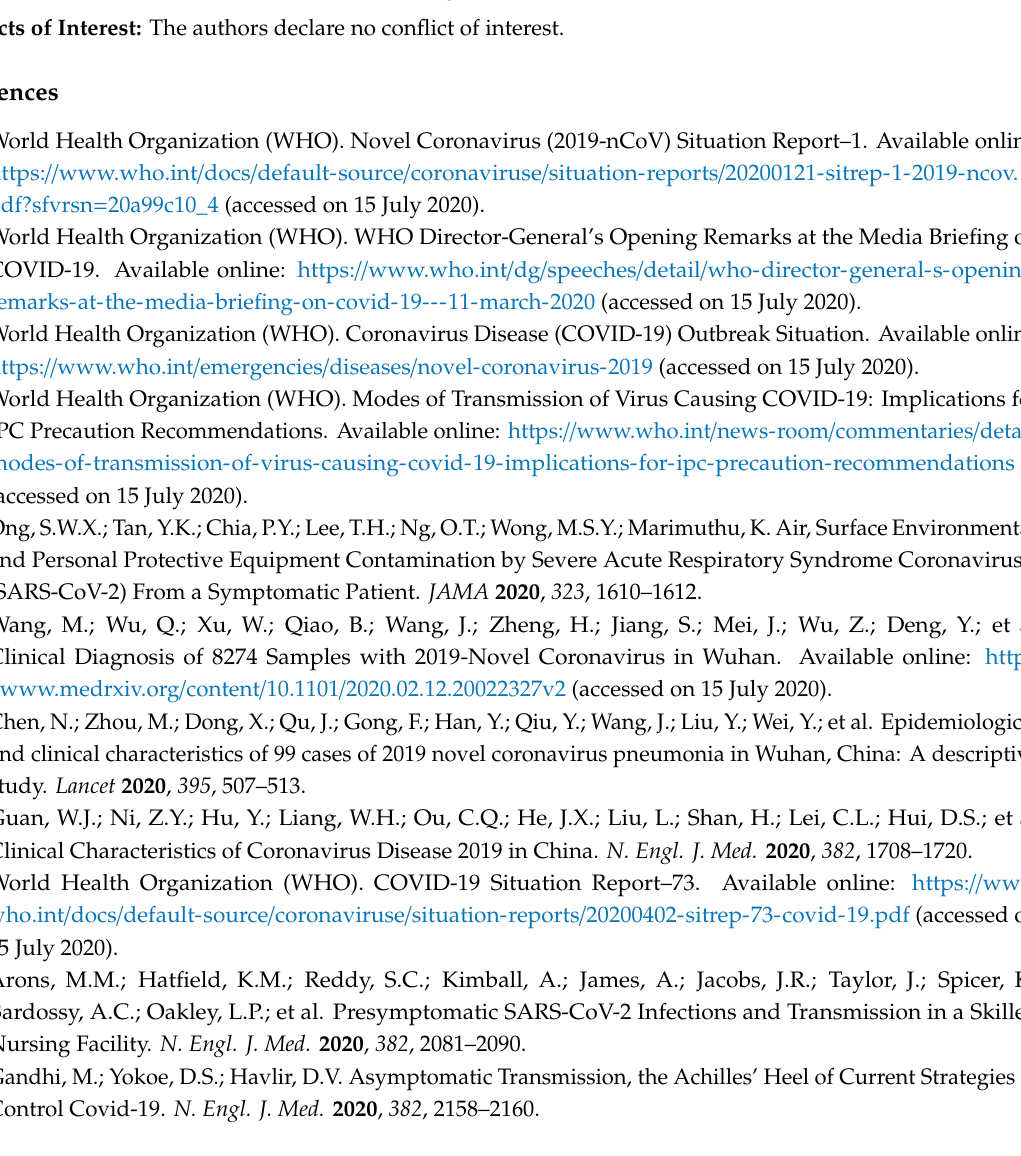
Table S1: Results of serological and molecular tests for SARS-CoV-2 for all enrolled